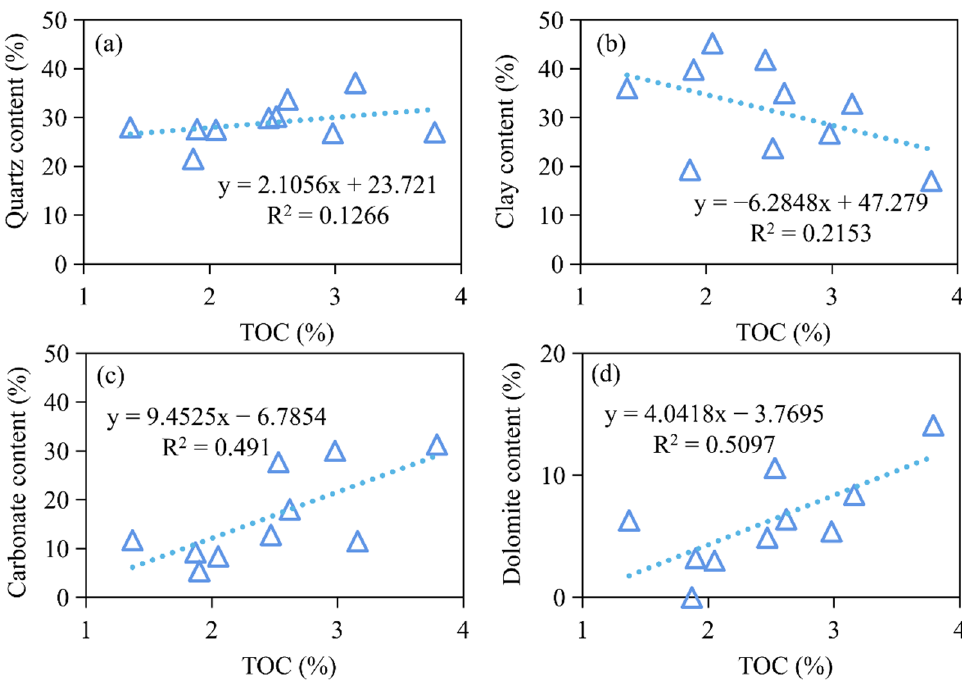
Figure 3. Correlations of TOC with quartz ( a ), clay ( b ), total carbonate ( c ), and dolomite ( d ) of the YC2 well samples.